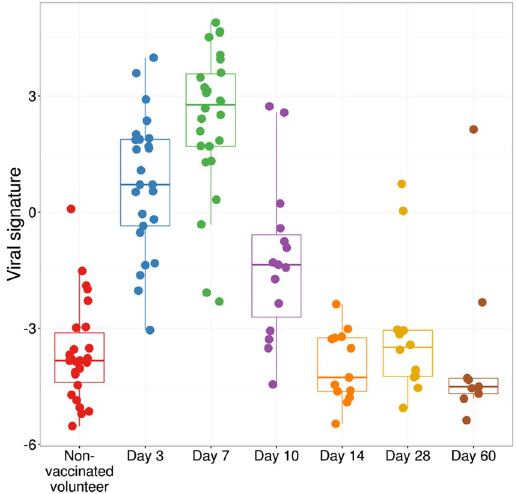
Figure 3. Time-course of pan-viral signature score for human volunteers vaccinated with live attenuated yellow fever vaccine. Box and whisker plot of the pan-viral signature values for 26 human volunteers vaccinated with Stamaril and followed for up to 60 days (GEO dataset GSE13699). The pan-viral value increased from day 3 post-vaccination and peaked on day 7. By day 14 the value had returned to pre-vaccination levels.